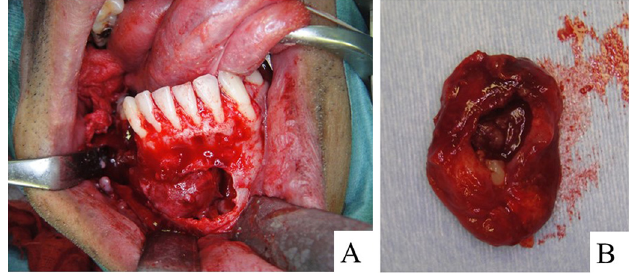
with cystic areas along with an embedded mandibular fi rst premolar in the tumor